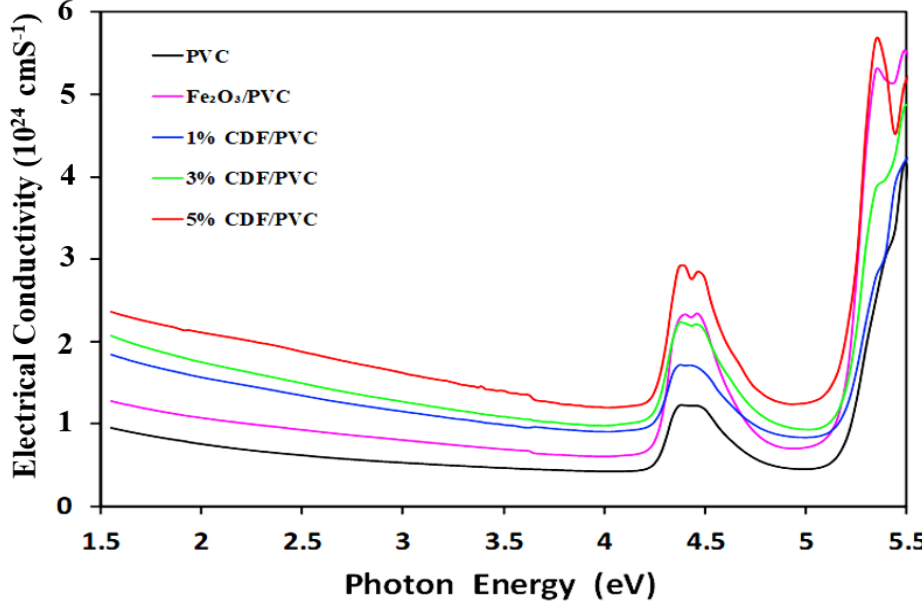
Figure 12. A comparison of electrical conductivity spectra of PVC and its composites.